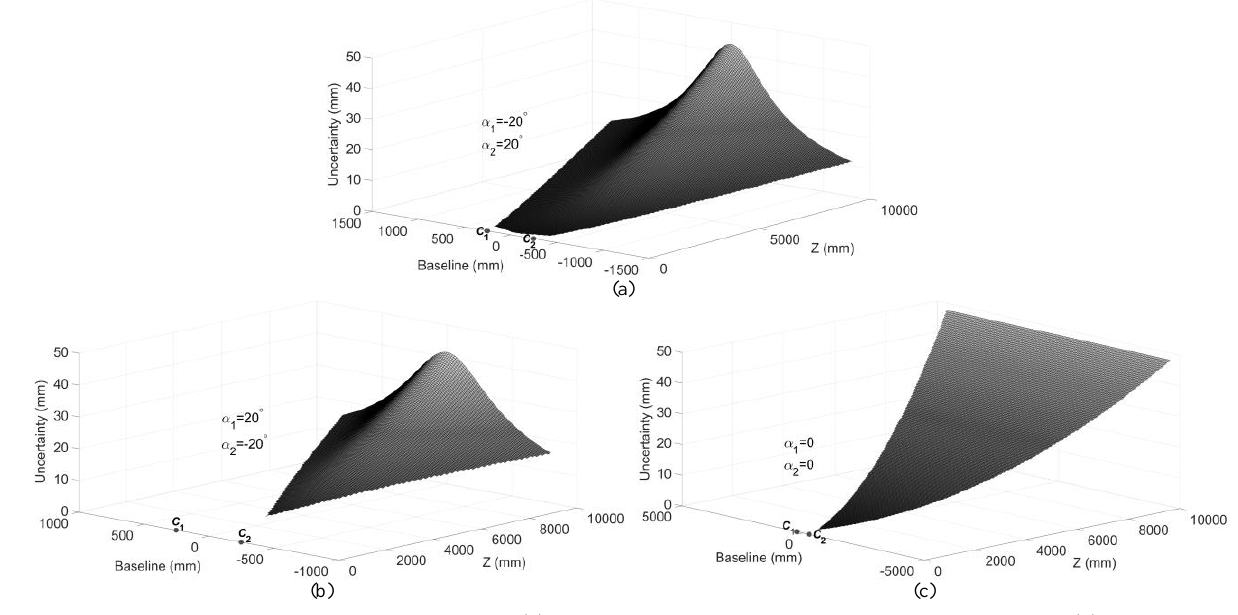
Figure 4. The uncertainty diagram for a typical (a) converged camera setup with 𝜶 𝟏 = −𝟐𝟎 and 𝜶 𝟐 = 𝟐𝟎 (b) diverged camera setup with 𝜶 𝟏 = 𝟐𝟎 and 𝜶 𝟐 = −𝟐𝟎 (c) rectified camera